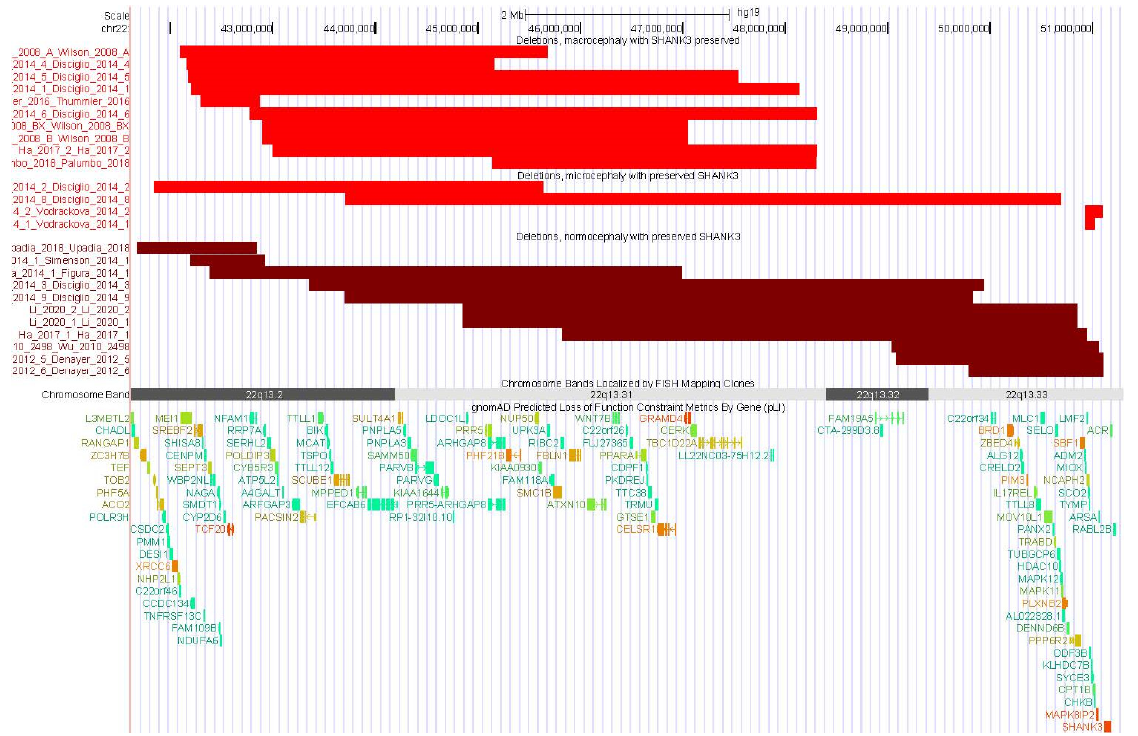
Figure 1. Distribution of deletions for individuals with macrocephaly ( top ), microcephaly ( middle ), and normocephaly ( lower ) with SHANK3 preserved. The graphic demonstrates the preponderance of deletions in the 22q13.2 and 22q13.31 bands for those with macrocephaly whereas individuals with normocephaly have deletions across all of 22q13. No pattern of deletions is apparent for microcephaly among those with SHANK3 preserved.